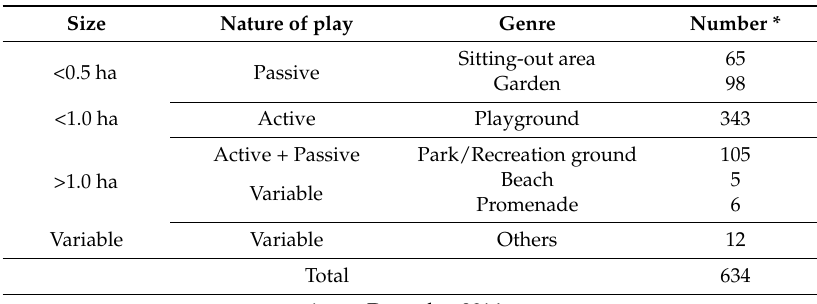
Table 1. Types of LCSD managed outdoor play space for children.